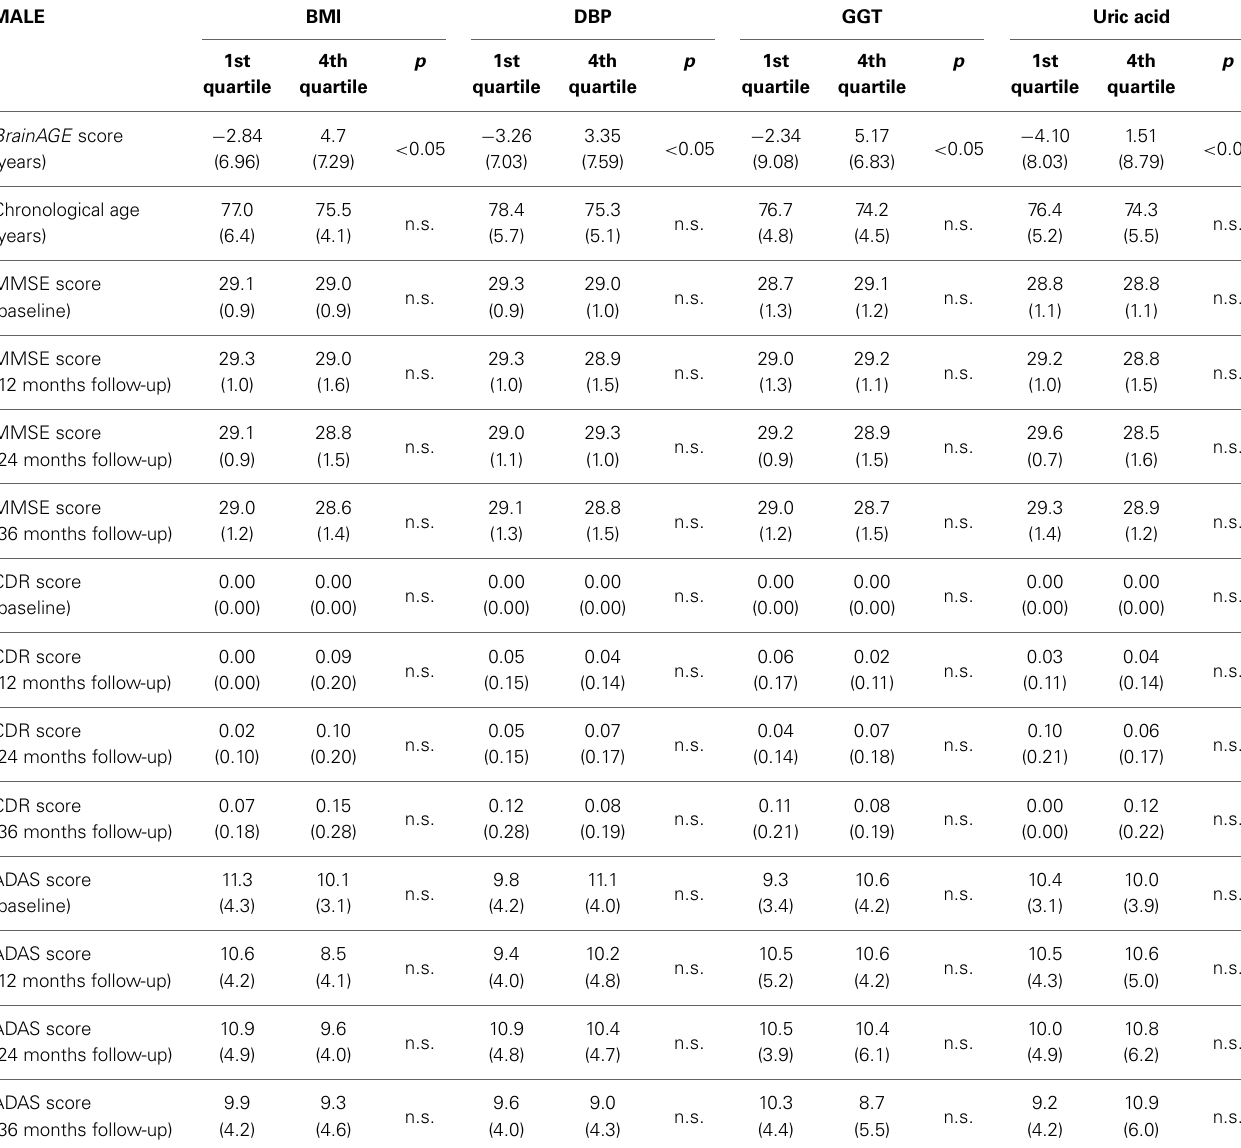
Table 4 | Means ( SD ) of BrainAGE scores, chronological age and cognitive scores in the 1st and 4th quartile groups of the four most significant physiological and clinical chemistry parameters within the male